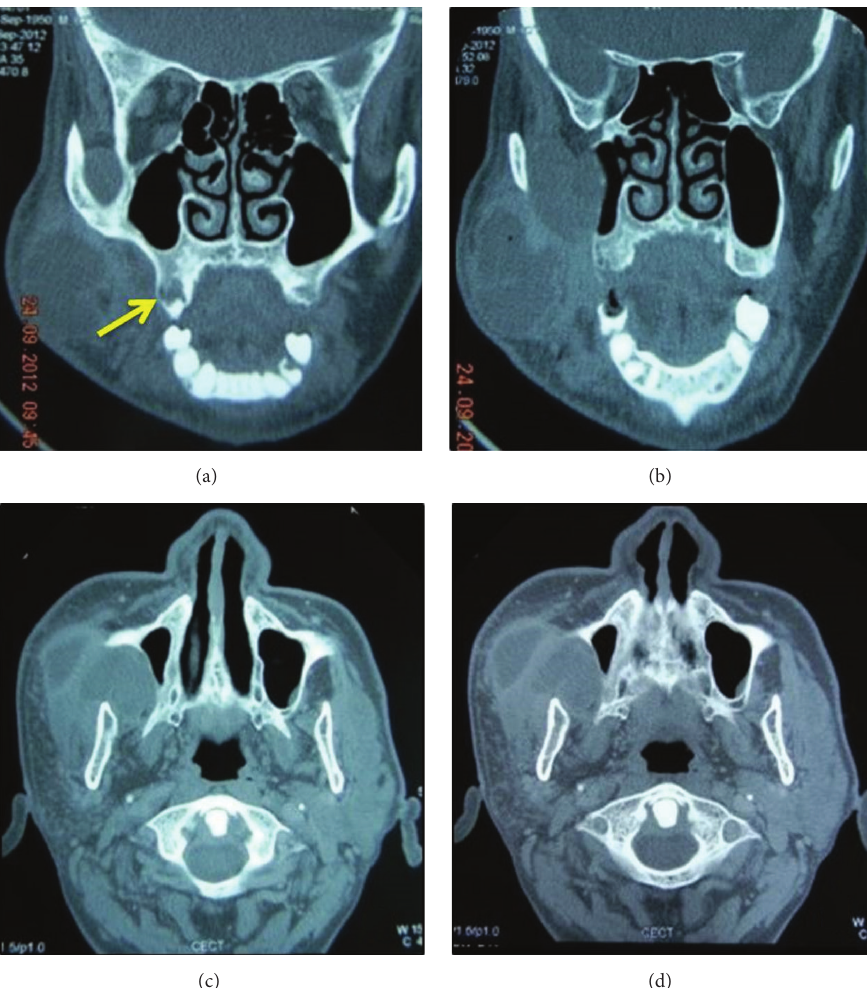
Figure 2: ((a) and (b)) Posteroanterior view; ((c) and (d)) transverse CT at C 6 level: CT scan showing a well-defined loculated soft tissue mass in the buccal space. The lesion shows multilocularity with gel or fluidic content. The lesion is seen compressing the maxillary bone in the area of antral wall laterally.